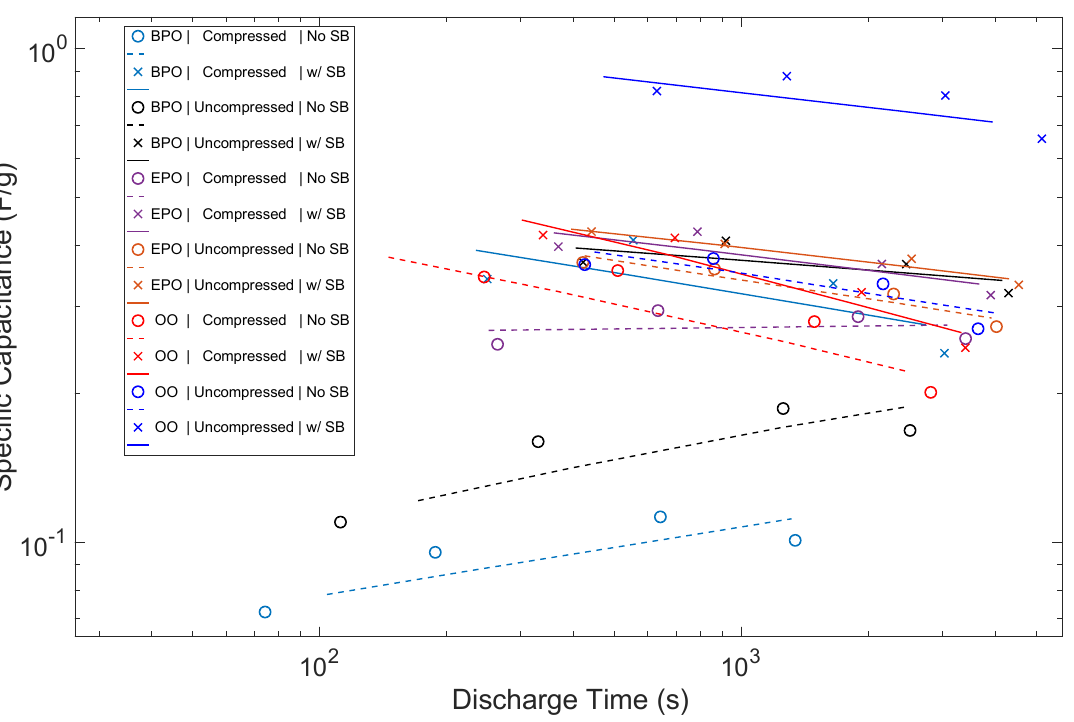
Figure 8. Capacitance as a Function of Discharge Time . Consistently, the presence of a salt bridge (solid lines) improves capacitance, all other factors were unchanged.